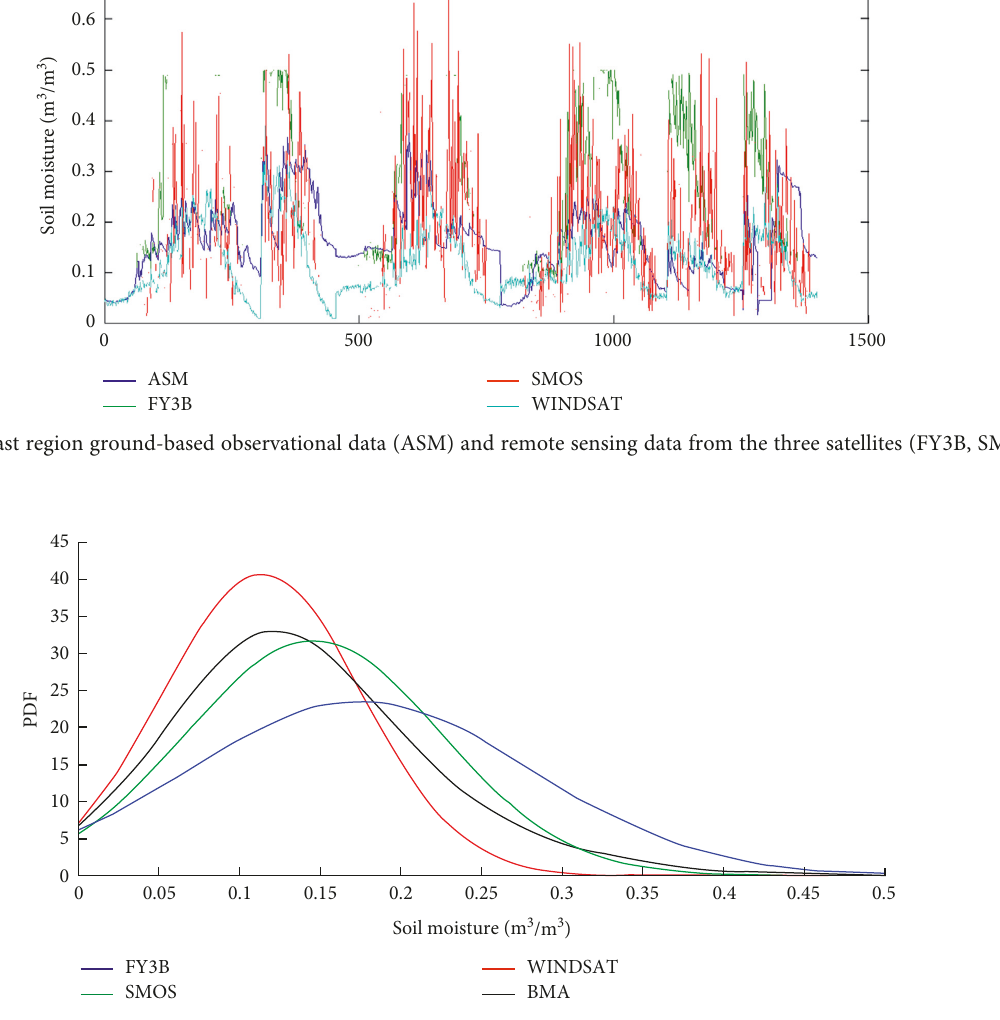
Figure 2: Northeast region satellite data and product of the BMA method after integration of the PDF